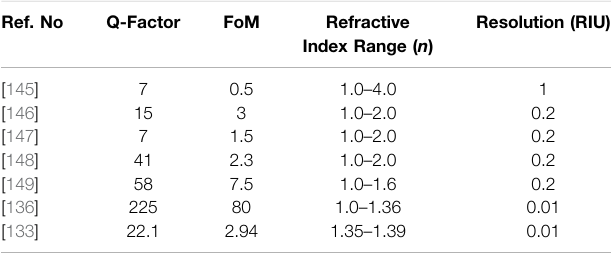
TABLE 4 | Comparison between the sensing performances of the existing absorbers. Ref.